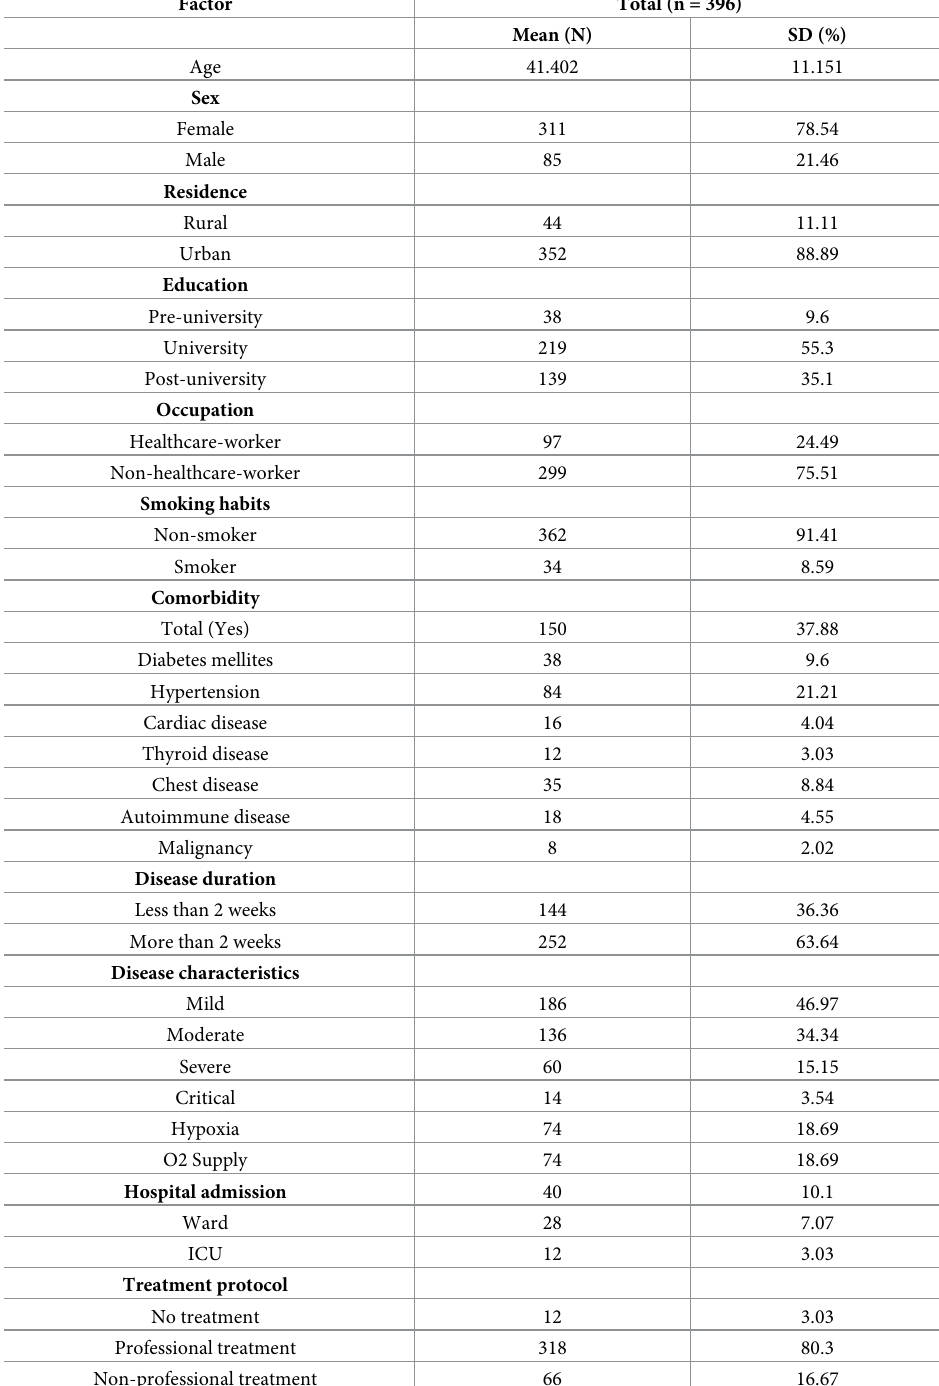
Table 1. Characteristics of participants in the